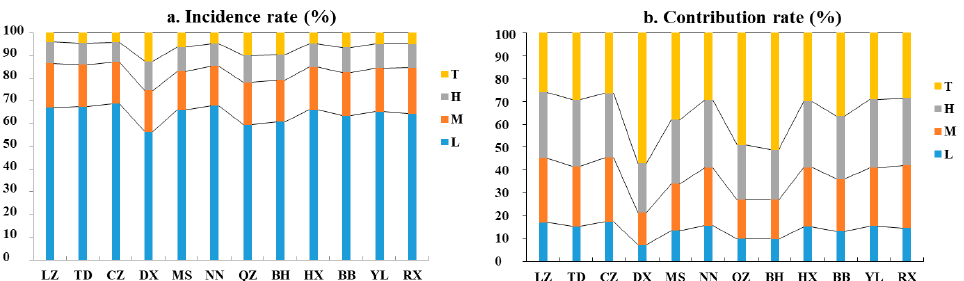
Figure 6. Incidence rate ( a ) and contribution rate ( b ) of different precipitation grades in rainy season at 12 stations in the Beibu Gulf.